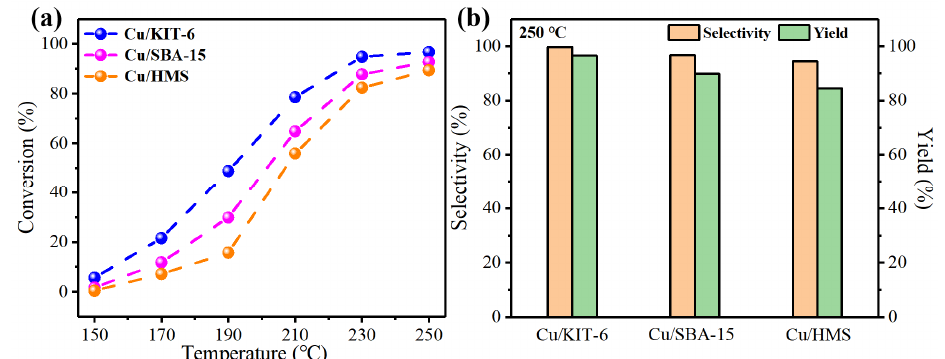
Figure 5. ( a ) Ethanol conversion, and ( b ) acetaldehyde selectivity and yield, of Cu/KIT-6, Cu/SBA-15, and Cu/HMS catalysts. Reaction condition: a reactant ethanol stream of 2 kPa balanced by N 2 under atmospheric pressure, and WHSV of 13.67 mmol g −1Cu h −1 .